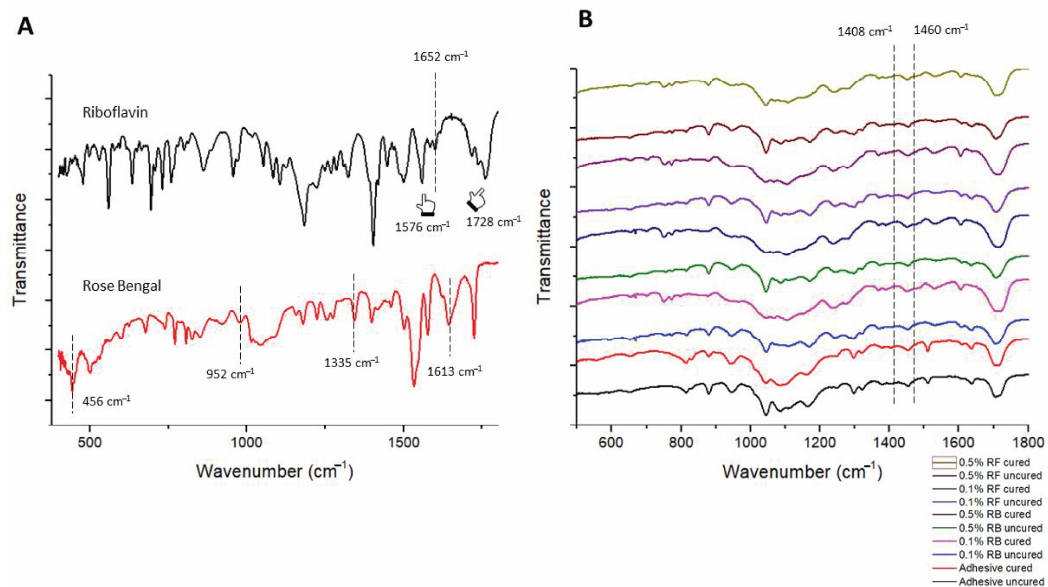
Figure 1. FTIR spectra of ( A ) riboflavin (black spectrum) and Rose Bengal (red spectrum) powder. Characteristic peaks at 1576 cm − 1 , 1652 cm − 1 , and 1728 cm − 1 are noted. The spectrum at 1728 cm − 1 indicates C=O stretching frequency of riboflavin. In the components, the aromatic C=C stretching mode of riboflavin appears at 1576 cm − 1 and 1652 cm − 1 (indicated with pointers). Rose-Bengal possesses important peaks at 456 cm − 1 which indicates C–I bonding, at 952 cm − 1 for C–C stretching vibration, and 1335 cm − 1 and 1613 cm − 1 for C=C stretching vibration and C=O stretching vibration, respectively. ( B ) After incorporating these powders in orthodontic adhesives, the ascribed peaks were evident forming strong bonds with the resin